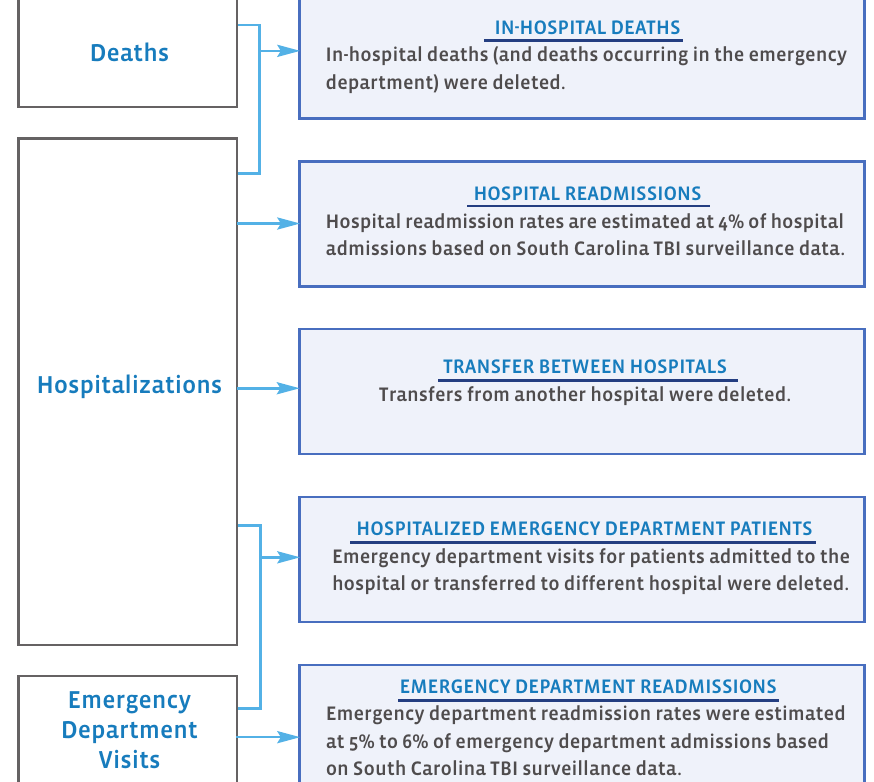
FIGURE 11: Sources of Potential Case Duplication When Combining Traumatic Brain Injury-Related Emergency Department Visits, Hospitalizations, and